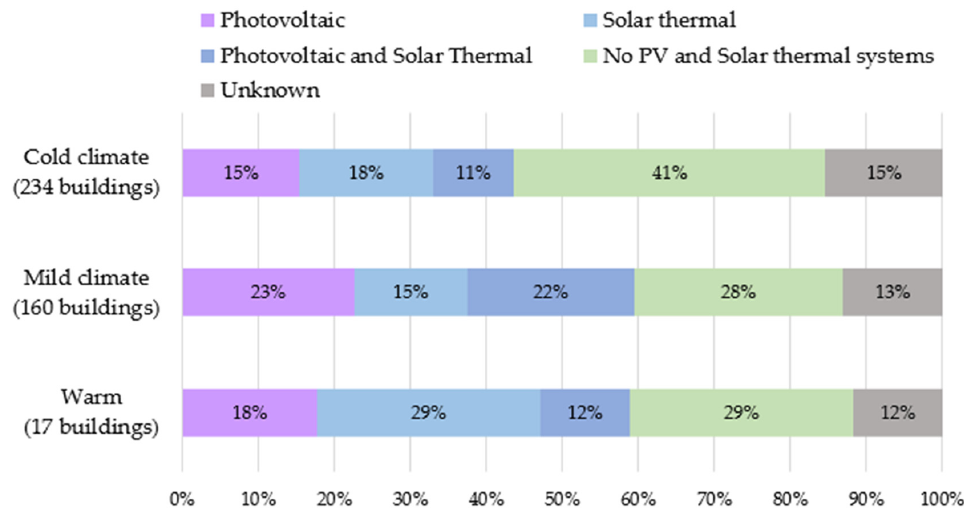
Figure 24. Share of PV and ST systems installed according to climatic zones. Figure 24 . Share of PV and ST systems installed according to climatic zones. Figure 24 . Share of PV and ST systems installed according to climatic zones.